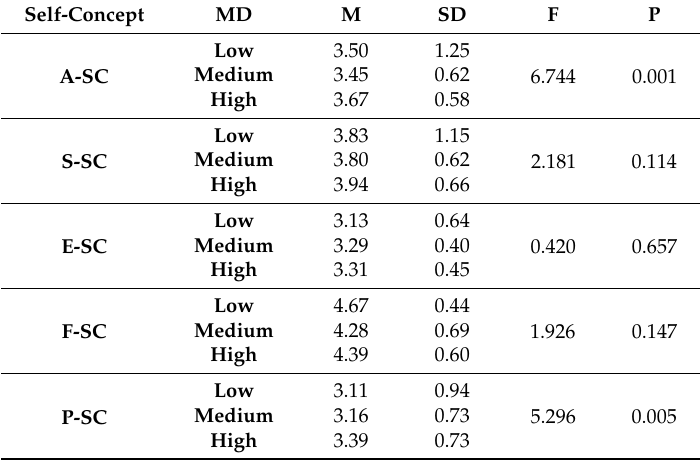
Table 4. Dimensions of self-concept according to adherence to the